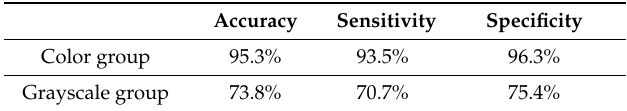
Table 3. Performance from incorporating 613 positive blocks and 1202 negative blocks with and without color information using the proposed